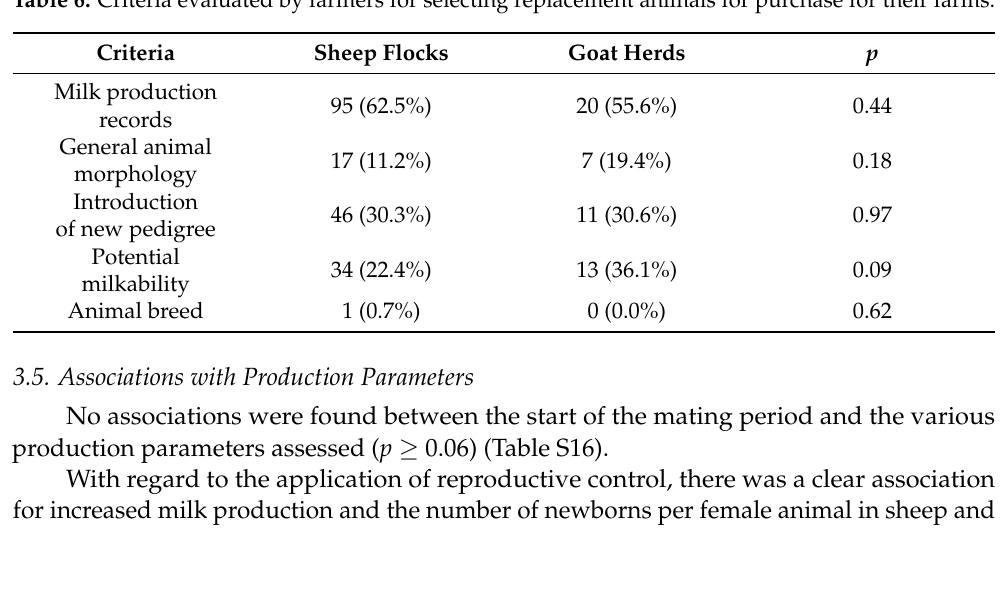
Table 6. Criteria evaluated by farmers for selecting replacement animals for purchase for their